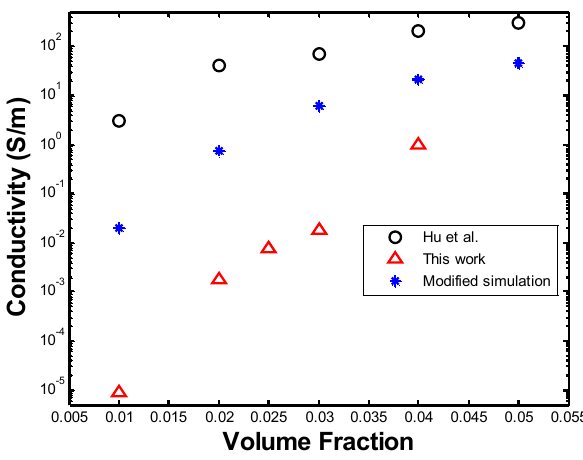
Figure 27. Comparison of [12] with modified simulation.